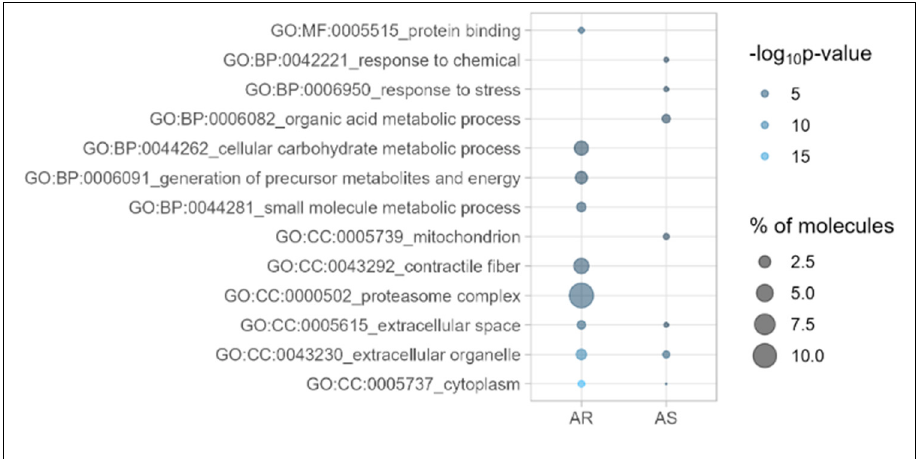
Figure 2. Functional enrichment analysis of list of proteins being positively associated with aortic